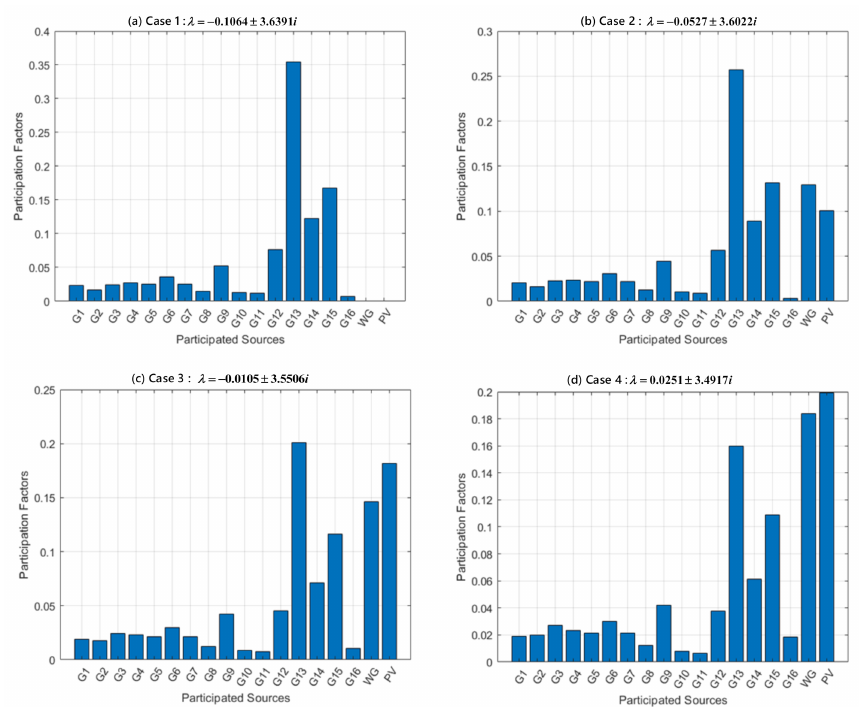
Figure 7. Participation factor analysis for closed-loop critical EOM (0.55 Hz–0.58 Hz). ( a ) Case 1; ( b ) Case 2; ( c ) Case 3; ( d ) Case